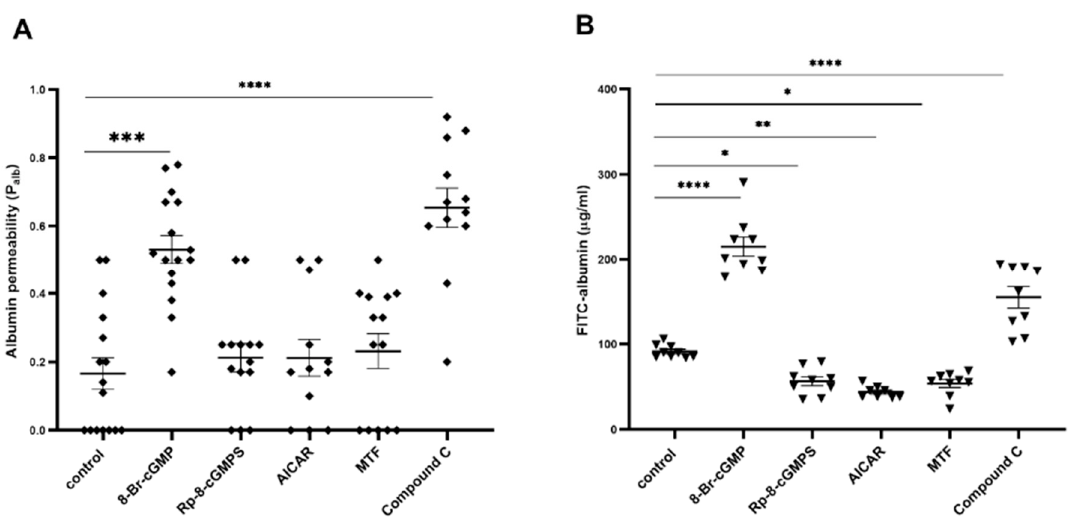
Figure 1. Opposing regulation of filtration barrier permeability by PKGI α and AMPK. Glomerular albumin permeability (P alb ) ( A ) was evaluated in isolated glomeruli that were exposed to an oncotic gradient, and transepithelial permeability to albumin was assessed by measuring the diffusion of FITC-labeled BSA across the podocyte monolayer ( B ) in the presence of the PKG activator, 8-Br-cGMP (100 µ M, 5 min) or the PKG inhibitor Rp-8-Br-cGMPS (100 µ M, 20 min) and AMPK activators